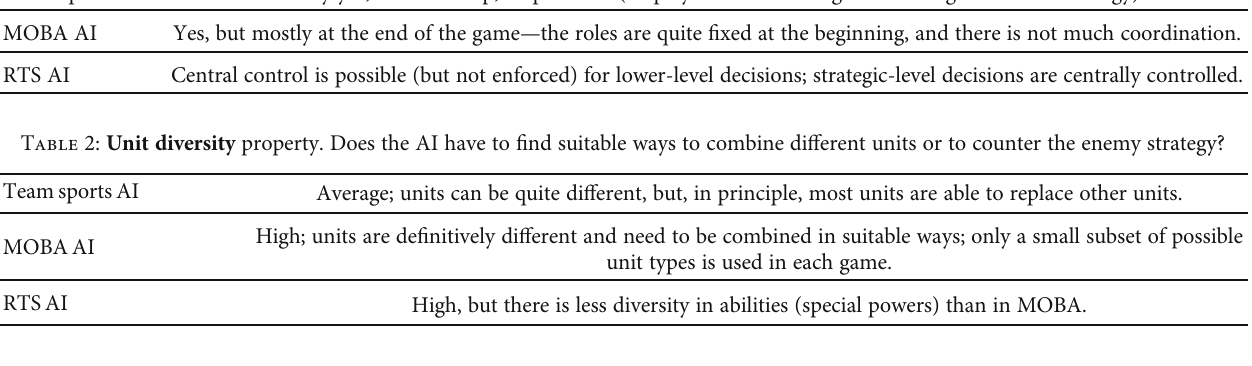
Table 1: Control property. Are there multiple autonomous agents? Team sports AI